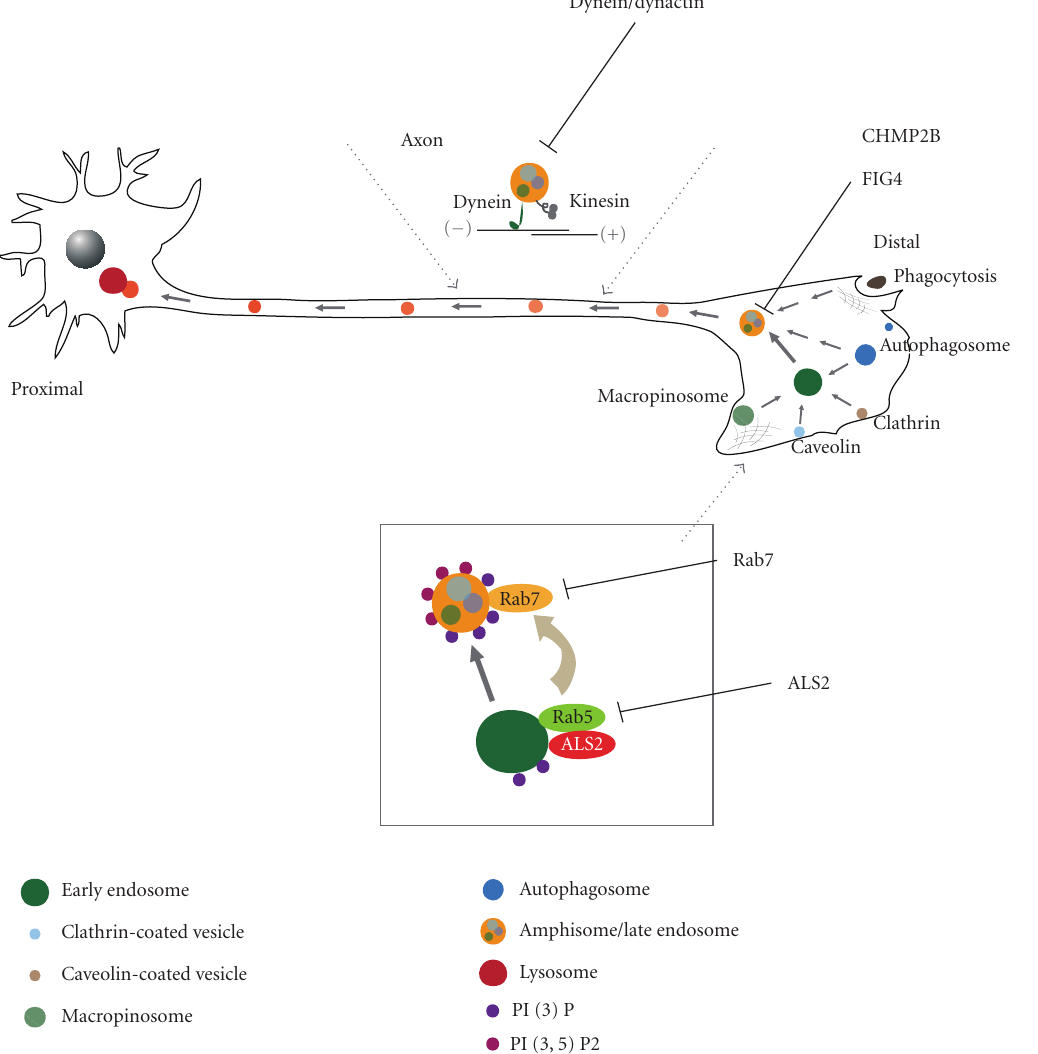
Figure 2: ALS-linked mutations in the genes, whose protein products are associated with autophagy-endolysosomal system and/or endocytic tra ffi cking, underlie the pathogenesis of ALS and related motor neuron